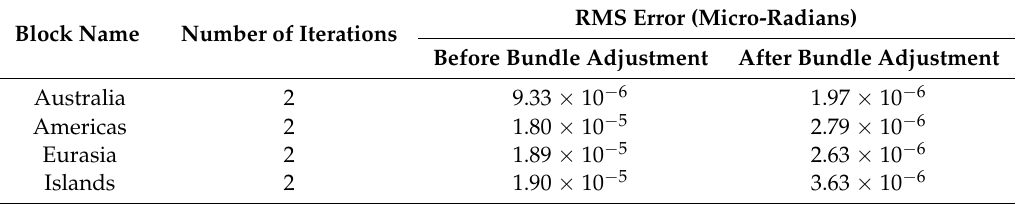
Table 5. Number of iterations and the initial and final root mean square (RMS) error of the observations in the bundle adjustment for each block. The Australia block showed smaller RMS error before bundle adjustment, as the GCPs were adjusted using the AGRI reference